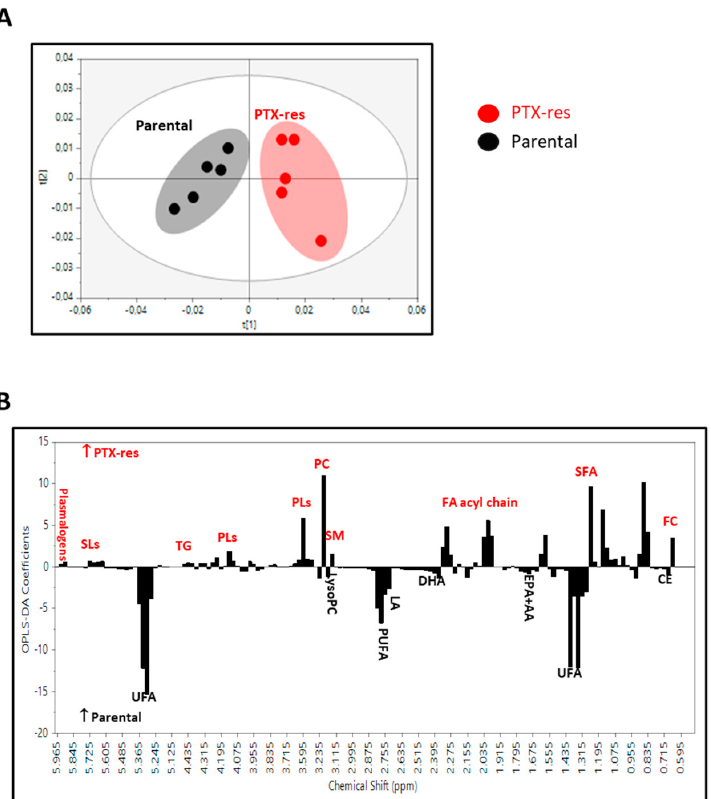
Figure 8. OPLS-DA score plot of the lipidomic data from ( Α ) SUM159 PTX-res cells (red circles) and SUM159 parental cells (black circles); ( B ) the corresponding regression coefficient plot colored according to the correlation between the NMR lipidomic data and the group studied.